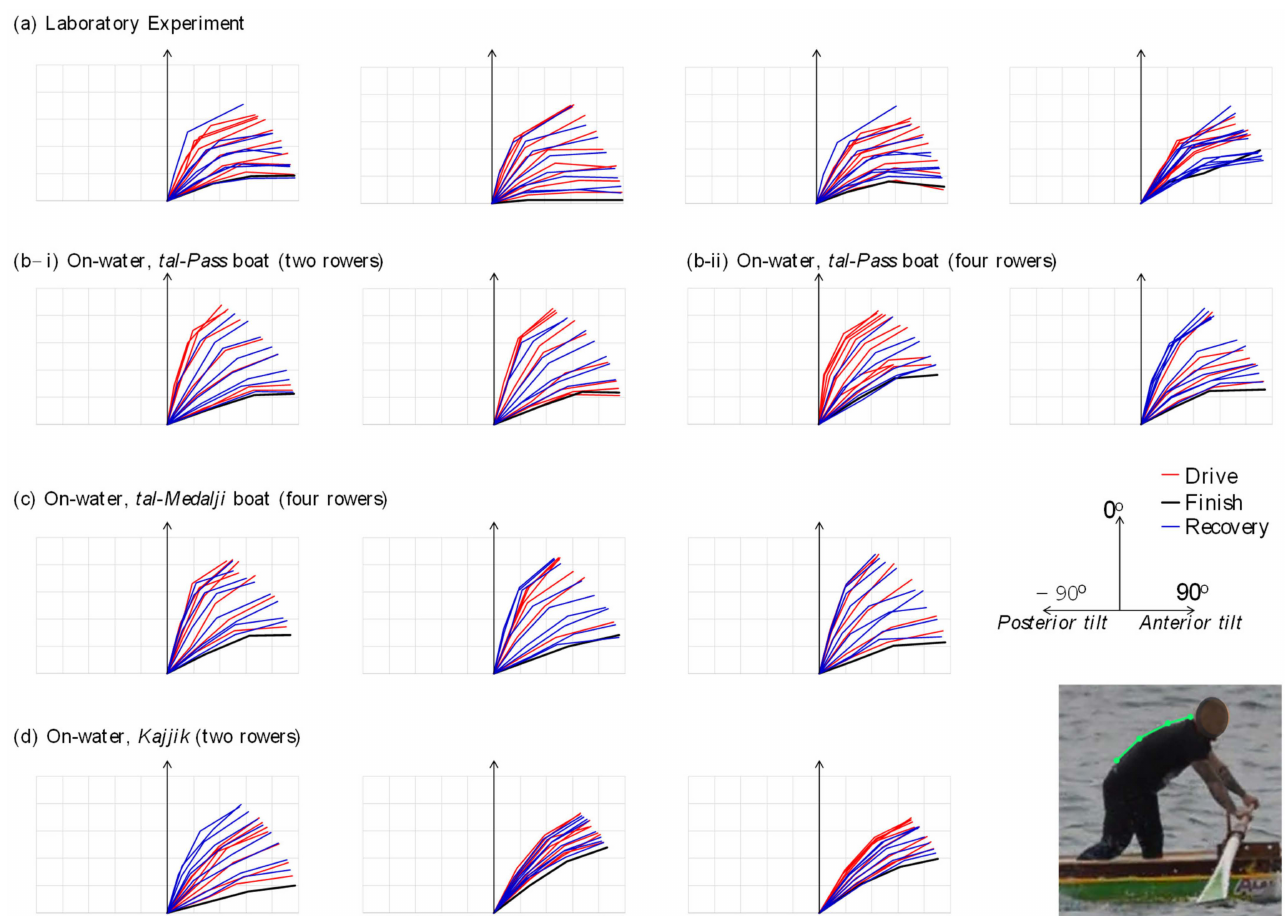
Figure 7. Images showing the typical outline of the back profiles traced from images extracted from video of on-water rowing and the lab study for standing rowing, where ( a ) shows cycles from each of the different rowers in the laboratory study, whilst ( b – d ) refer to the equivalent profiles from rowers rowing on different types of boats. The boats studied are all traditional Maltese rowing racing boats where ( b ) is the widest and heaviest Tal-Pass boat which can be rowed by two rowers, one sitting one standing ( b-i ), or four rowers, two sitting, two standing ( b-ii ); ( c ) refers to the more slender, slightly longer, and lighter Tal-Medalji version, also rowed by four rowers, two sitting, two standing whilst ( d ) refers to the much shorter Kajjik , rowed by two rowers, one sitting, one standing. The rower analysed is always the standing rower with the oar on his right-hand side ( parasija ). The manner of how these profiles were drawn is illustrated in the insert. Note that profiles refer to rowers facing the right